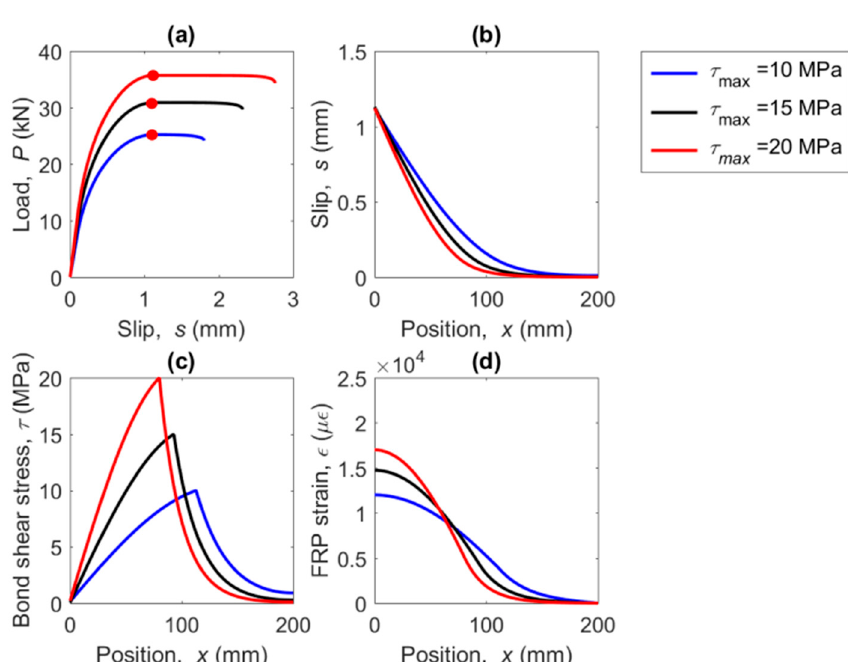
Figure 14. (a) Load–slip curve, (b) slip along the FRP, (c) bond–shear stress along the FRP, and (d) Figure 14. ( a ) Load–slip curve, ( b ) slip along the FRP, ( c ) bond–shear stress along the FRP, and ( d ) strains strains along the FRP for three values of bond–shear strength and a bilinear bond–slip law. along the FRP for three values of bond–shear strength and a bilinear bond–slip